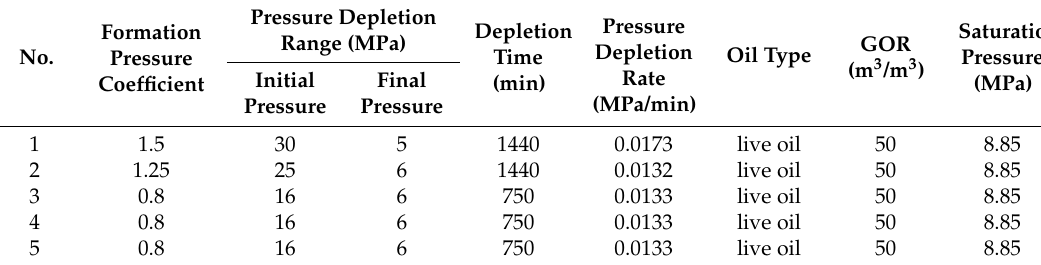
Table 7. Experimental conditions of live oil depletion under different initial formation